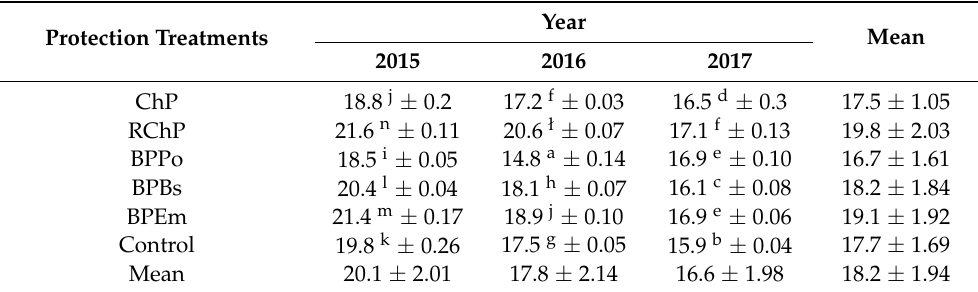
Table 8. Effect of protection treatments and year of horseradish cultivation on protein content (g · 100 g − 1 dry matter).